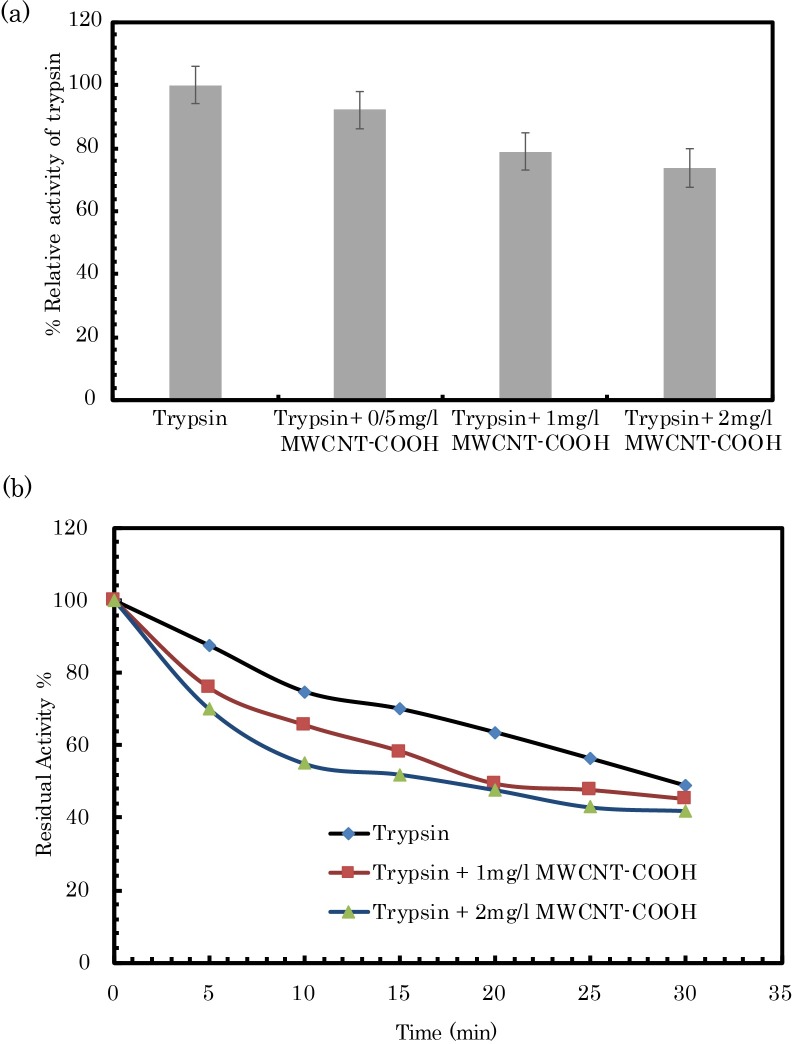
(a) Effects of COOH-f-MWCNTs on the activity of trypsin. (b) The thermostability of trypsin in the presence of COOH-f-MWCNTs. pH 8.0, T = 330 K: C
trypsin (control) = 100 μg/ml. CCNTs are in the total volume of the reaction mixture; pH 8.0, T = 298 K. Data are shown as mean values ± S.D.